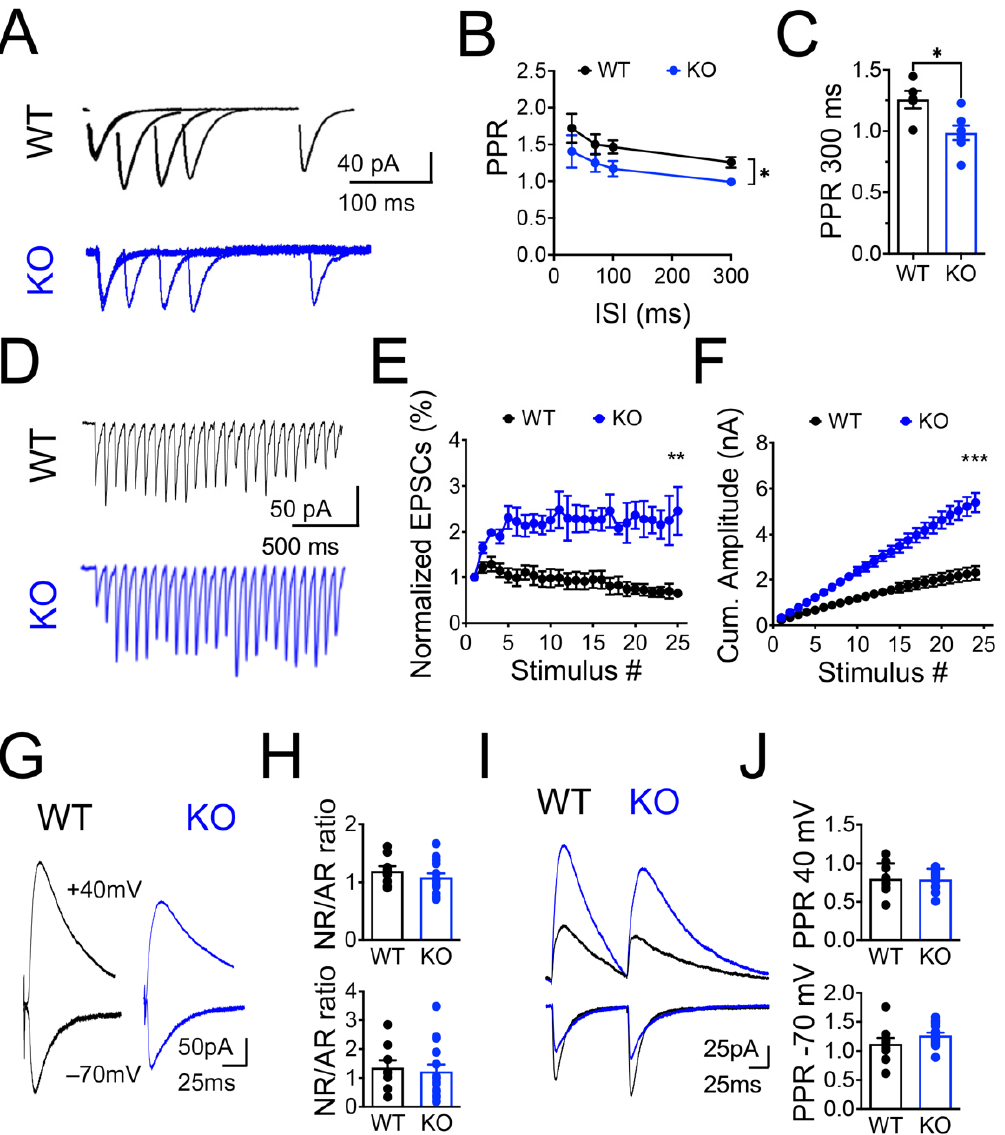
Figure 2. Readily releasable pool (RRP) and vesicle release probability are increased in Panx1-KO synapses. ( A ) Representative traces of superimposed paired-pulse responses at variable inter-stimulus intervals (ISI) from WT (black) and Panx1-KO (KO, blue) CA1 neurons. ( B ) Analysis of the paired-pulse facilitation ratio (PPR). n = 5 (WT) and n = 7 (KO) cells from 4–5 animals, * p = 0.0074 two-way ANOVA test. ( C ) PPR at 300 ms ISI. * p = 0.0144 Mann–Whitney test. ( D ) Representative traces of EPSCs were evoked by a train of 25 pulses at 10 Hz. ( E ) Normalized values of EPSCs. n = 5 (WT) and n = 7 (KO) slices from 4–5 animals, ** p = 0.0017 two-way ANOVA test. ( F ) Plot of the cumulative EPSCs versus number of stimuli. n = 5 (WT) and n = 7 (KO) slices from 4–5 animals, *** p =0.002 two-way ANOVA test. ( G ) Representative traces of the NMDAR and AMPAR currents. ( H ) Analysis of AMPAR to NMDAR (AR/NR) ratio recorded at 40 mV ( top ) and − 70 mV ( bottom ). ( I ) Representative traces of AMPAR and NMDAR currents induced by a paired-pulse (at 50-ms intervals). ( J ) Analysis of paired-pulse ratio (PPR) recorded at 40 mV (top) and –70 mV ( bottom ).